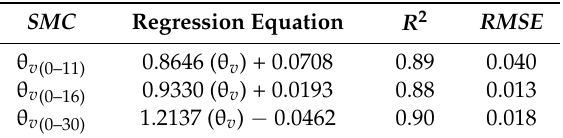
Figure 2. Comparison of the measured θ v using the HD2-TDR and calculated θ v by using the measured θ g and bulk density at Pynn’s Brook Research Station. Table 1. Linear regression, coefficient of determination ( R 2 ) and root mean square error ( RMSE ) for